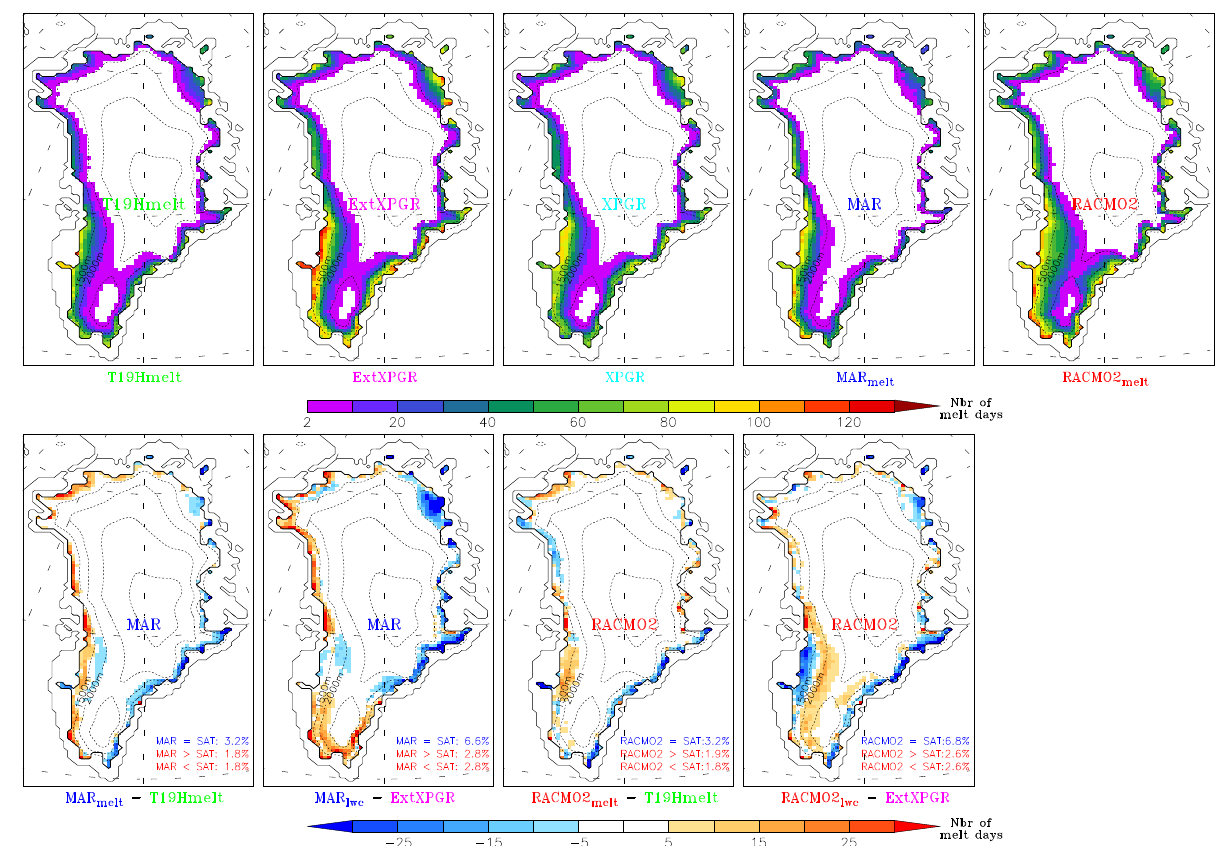
Fig. 4. Top – Annual mean total number of melt days derived from Fig. 4. Top – annual mean total number of melt days derived from the spaceborne passive microwave data and simulated by the RCMs the spaceborne passive microwave data and simulated by the RCMs using algorithms described in Table 2. Below – the difference between models and the T19H melt and ExtXPGR algorithms. The mean using algorithms described in Table 2. Below – The difference be- number of GrIS pixels when RCM and the algorithms detect melt (RCM=SAT), when RCM detects melt but the retrieving algorithms do tween models and the T19Hmelt and ExtXPGR algorithms. The not (RCM > SAT) and when RCM does not detect melt while the algorithms do, (RCM < SAT) is also listed as a percentage of the number mean number of GrIS pixels when RCM and the algorithms detect of GrIS pixels × summer melt (RCM=SAT), when RCM detects melt but the retrieving algo- rithms do not (RCM > SAT) and when RCM does not detect melt while the algorithms do (RCM < SAT) is also listed as a percentage of the number of GrIS pixels (cid:2) summer days.